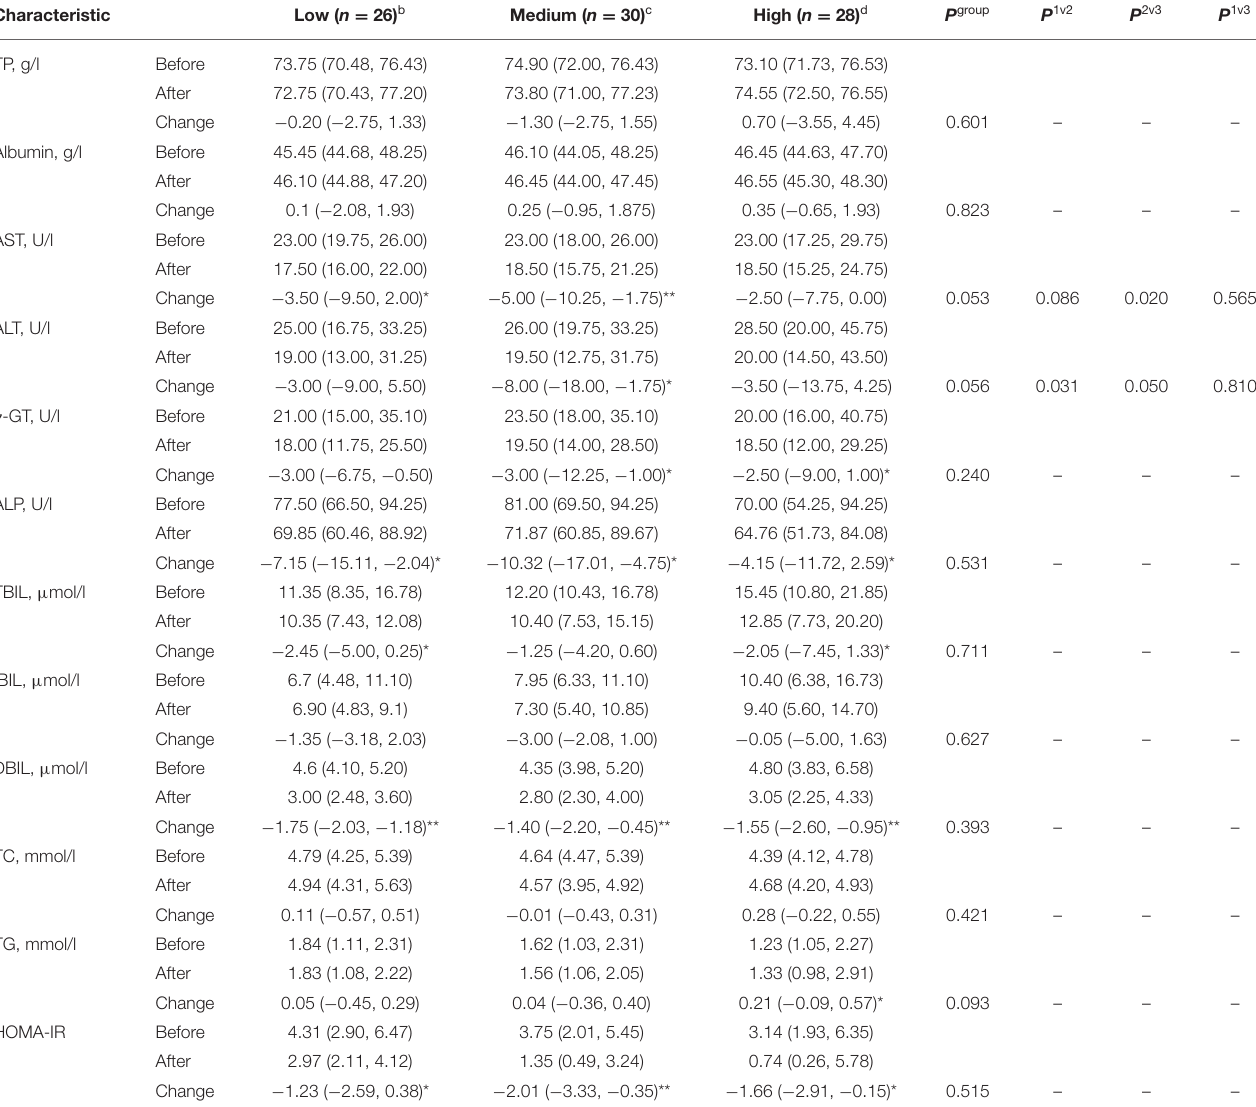
TABLE 2 | Metabolic indicators change during the trial a